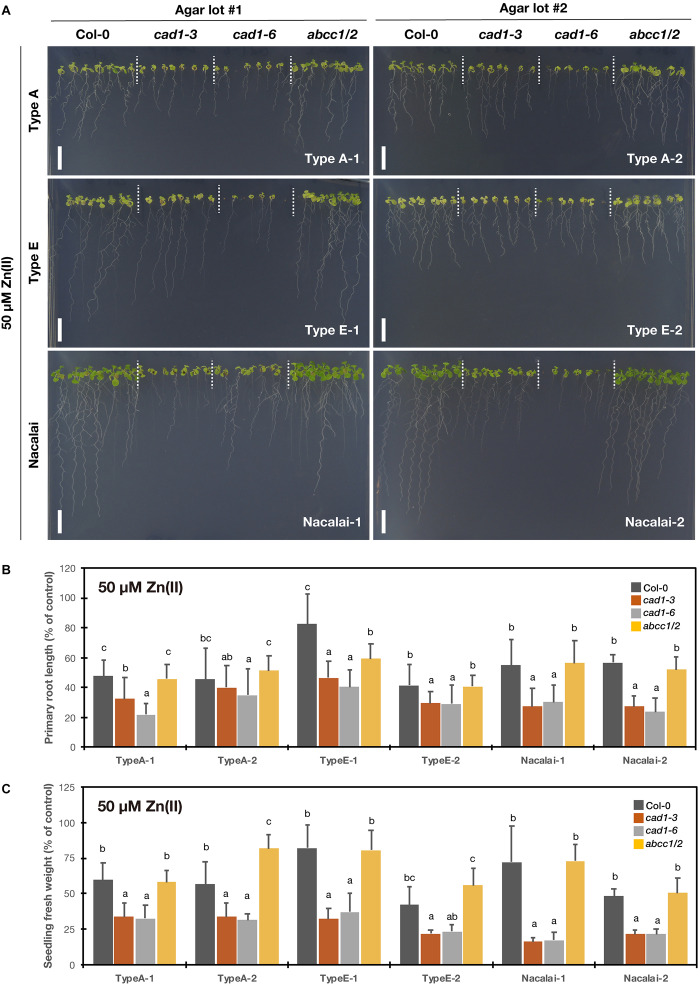
Excess Zn(II)-sensitivity of the phytochelatin-related Arabidopsis mutants on the agar plates prepared with different agar reagents. Three types of agar reagents with two independent lots for each type were tested. Col-0, cad1-3, cad1-6, and abcc1/2 were grown on the agar medium containing 50 μM Zn(II) for 12 days. (A) Phenotypes of Col-0, cad1-3, cad1-6, and abcc1/2. Scale bars = 1 cm. (B,C) Relative primary root length (B) and fresh weight of seedlings (C) of Col-0, cad1-3, cad1-6, and abcc1/2. Values are shown as percentage of each control. Data represent means with SD from at least three independent experiments (n = 22–28 for root length, and n = 3–4 for seedling fresh weight). Means sharing the same letter are not significantly different within each agar reagent (P < 0.05, Tukey’s HSD).